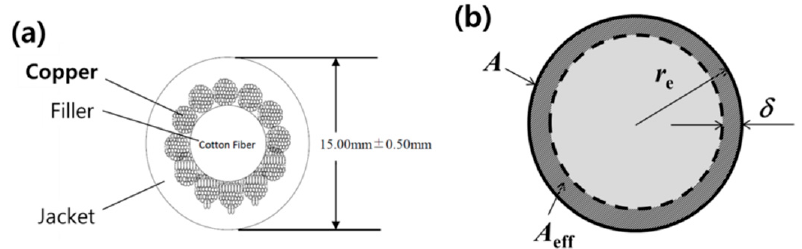
Figure 1. Schematics for modeling of Litz wire: ( a ) Distribution of actual wire and ( b ) effective area ( A eff ) of Litz wire due to skin effect. Here, A is the overall area of the cable, r e is the effective radius, and δ is the skin depth in the cable.